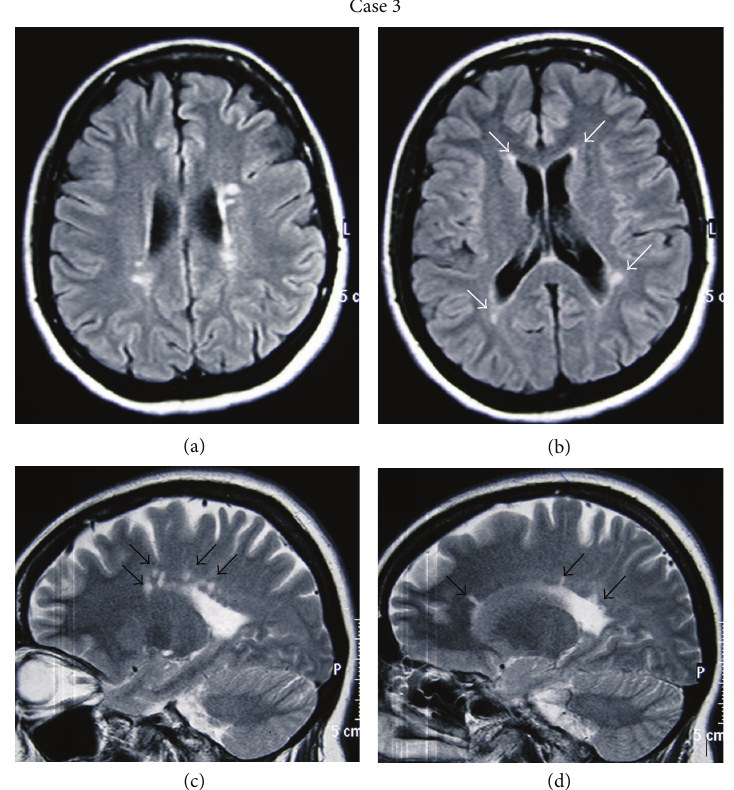
Figure 3: (a) and (b) Axial FLAIR brain MRI images of the third patient demonstrating multiple periventricular and subcortical lesions at the parietal and temporal lobes (white arrows). (c) and (d) Sagittal T2-weighted brain MRI images showing multiple lesions of the corpus callosum (black